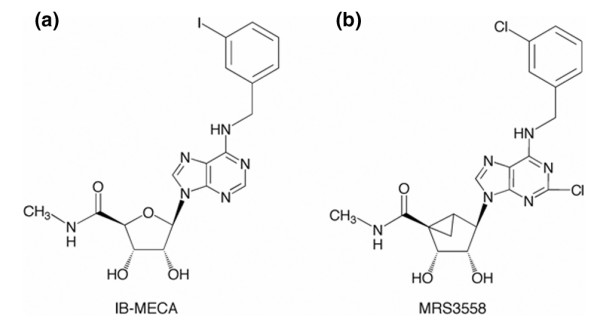
Structures of the two A3AR-selective agonists used in the study. (a) IB-MECA is a 9-riboside derivative, a structural feature shared with native adenosine. (b) The more potent and selective agonist MRS3558 contains a modified methanocarba ring system in place of ribose. The methanocarba substitution consists of fused cyclopentane and cyclopropane rings, which serve to constrain this moiety in a conformation that is preferred in the A3AR binding site. Both analogs share the N6-benzyl-type substitution, which is particularly suited for high affinity at the A3AR in various species. The methylamide moiety attached at the 4'-position serves to increase A3AR affinity and to maintain full efficacy in A3AR activation. The 2-chloro substitution of MRS3558 enhances A3AR affinity and selectivity. AR, adenosine receptor.